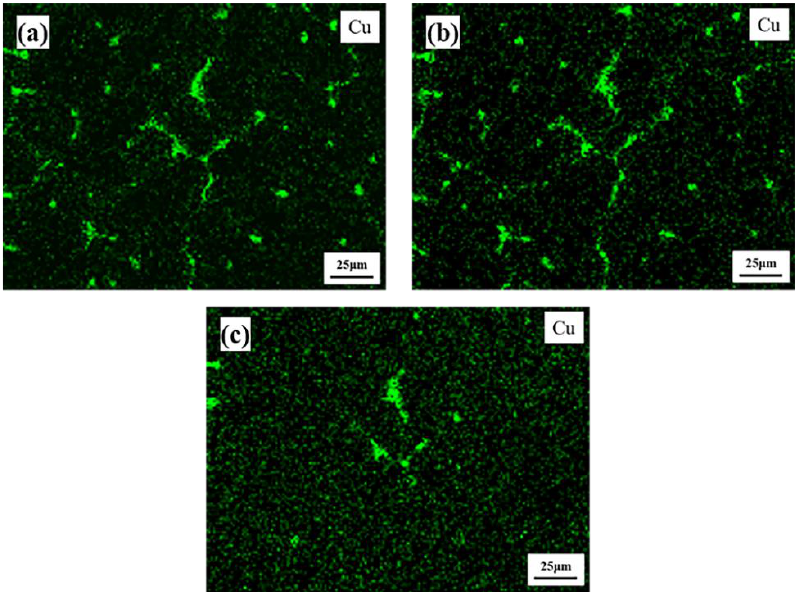
Figure 11. EDS elemental distribution of Cu with QISOZ magnification of 500 times at 400 °C ( a ), 450 °C ( b ) and 500 °C ( c ).